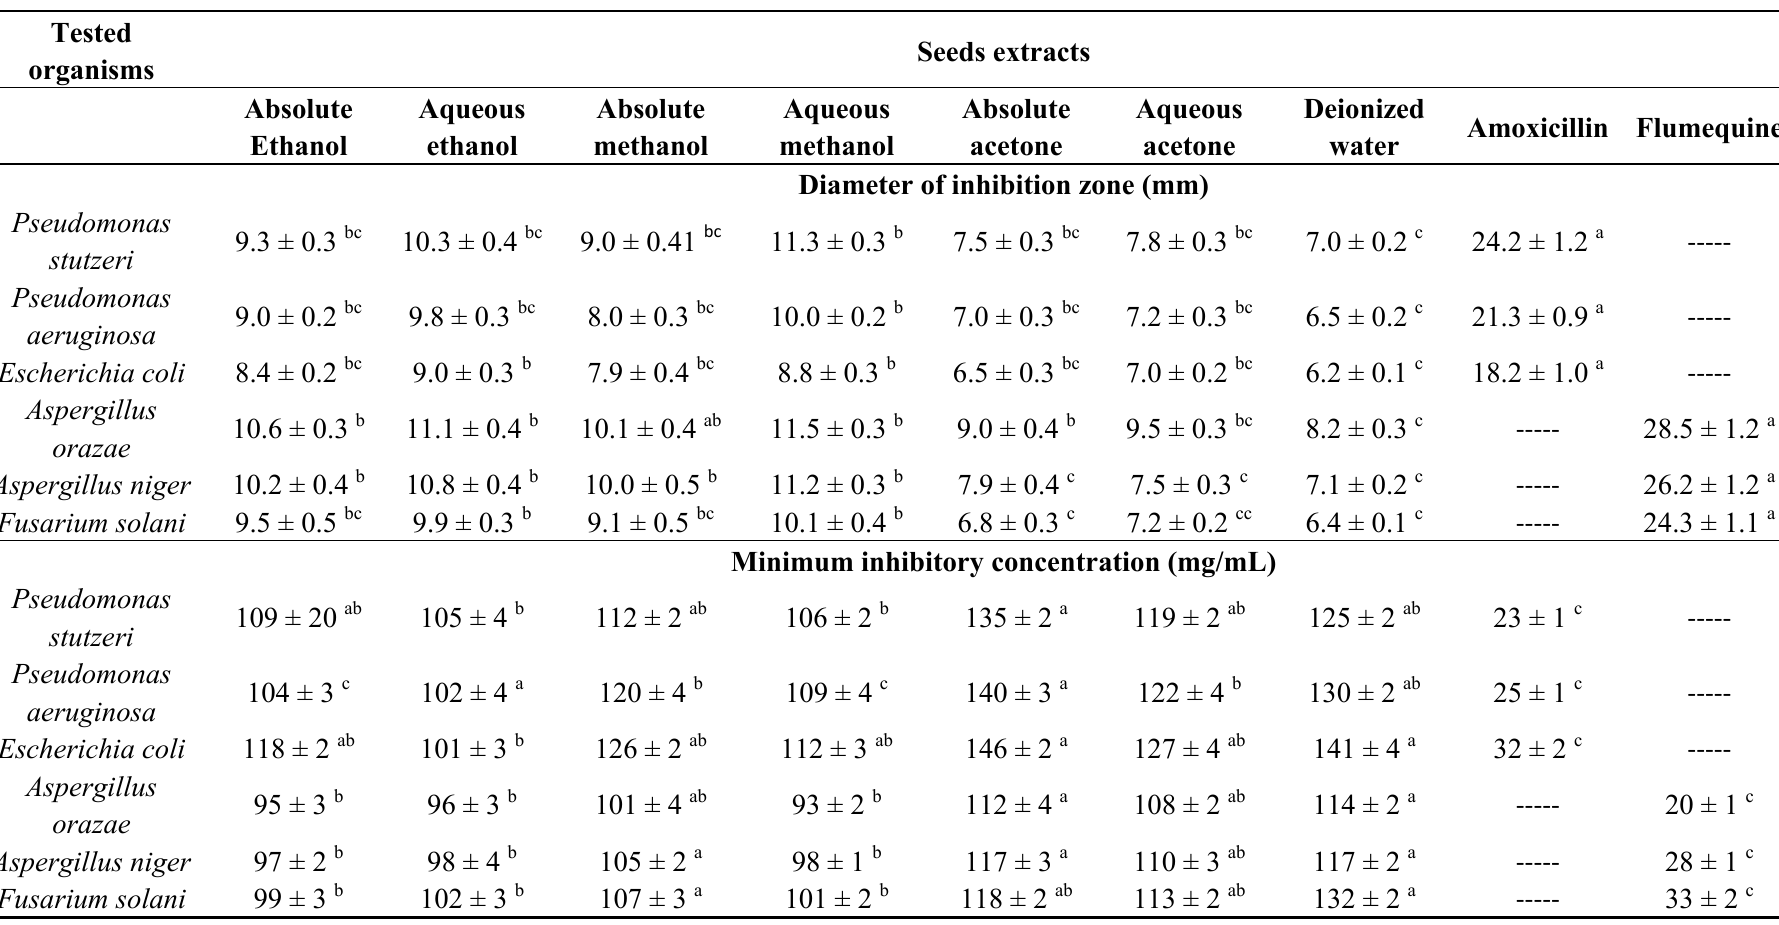
Values are mean ± SD of three separate experiments. Different superscript letters within the same row indicate significant ( p < 0.05) differences of means within the extracting